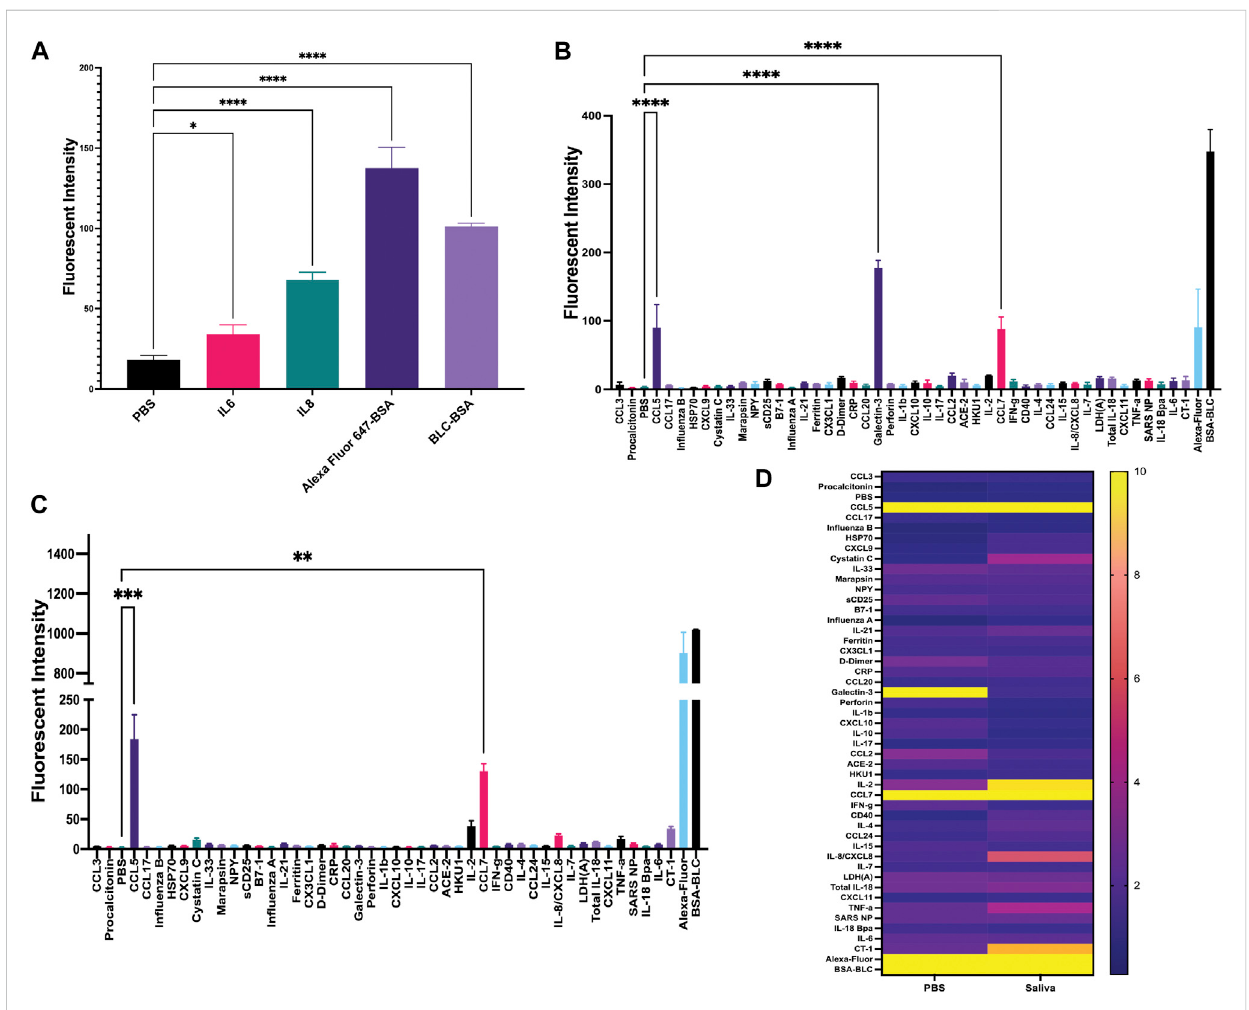
FIGURE 2 Development of sandwich-based ELISA assay on a gold-coated nanoscale grating surface chip. (A) Capture antibodies for IL-6 and IL-8 were immobilized onto the chip, along with the negative control (PBS) and two positive controls; biotin-BSA (BLC-BSA, to show streptavidin binding) and Alexa fl uor647-BSA (toshowstabilizationduringwashing),20 ng/mLofrecombinantIL-6andIL-8were fl owedoverthechip.The fl uorescenceintensity was collected as previously described. Fluorescent intensity within the ROIs for IL-6, IL-8 and positive controls was signi fi cantly higher than the negativecontrol. (B) Forty-twocaptureantibodieswereimmobilizedontothechip,20 ng/mLeachofrecombinantCCL5,galactin-3andCCL7dilutedin PBSwasrunoverthechipandthe fl uorescenceintensitywascollectingforeachROIaspreviouslydescribed.The fl uorescentintensitywithintheROIsfor CCL5, galactin-3 and CCL7 were signi fi cantly higher than the negative control. (C) Forty-two capture antibodies were immobilized onto the chip, 20 ng/ mL of recombinant protein CCL5 and CCL7 diluted in human saliva was run over the chip and the fl uorescence intensity was collected for each ROI as previouslydescribed.The fl uorescentintensitywithintheROIsforCCL5andCCL7weresigni fi cantlyhigherthanthenegativecontrol. (D) Aheatmapwas generatedusingthedetectionratio,whichwasnormalizedtothenegativecontroltocomparedatainBand (C) .One-wayANOVAanalysiswasperformed (* = p < 0.05, ** = p < 0.01, *** = p < 0.001, **** = p < 0.0001. The data are presented as the average of fi ve ROIs for each analyte ( ± standard error of the